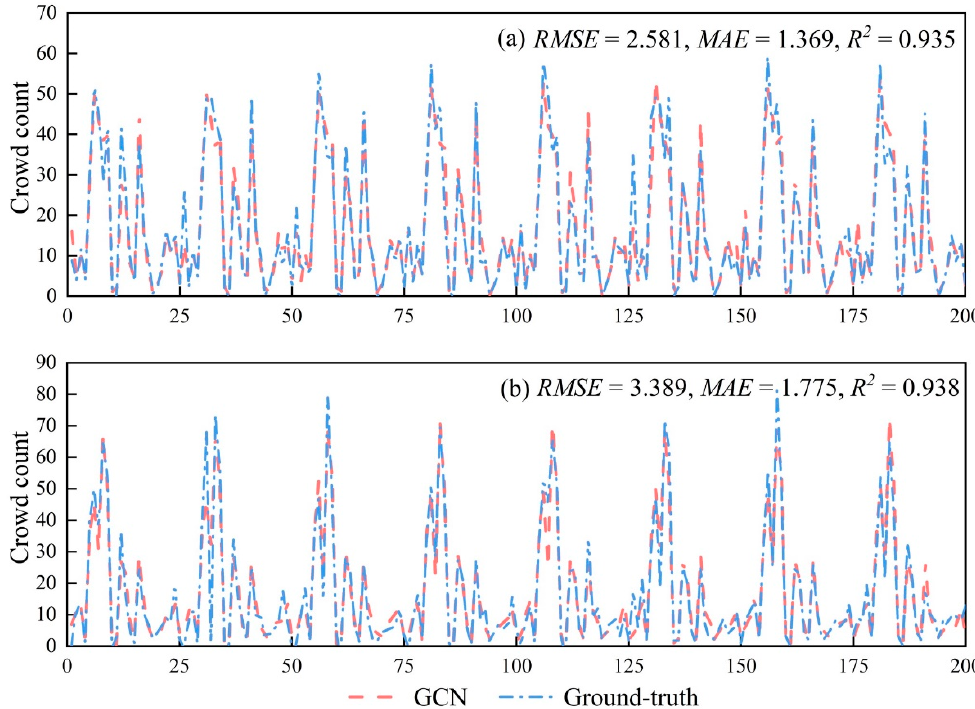
Figure 5. The GCN model performance and the visualization results of the ground-truth and predicted data on ( a ) weekdays; ( b ) weekends.